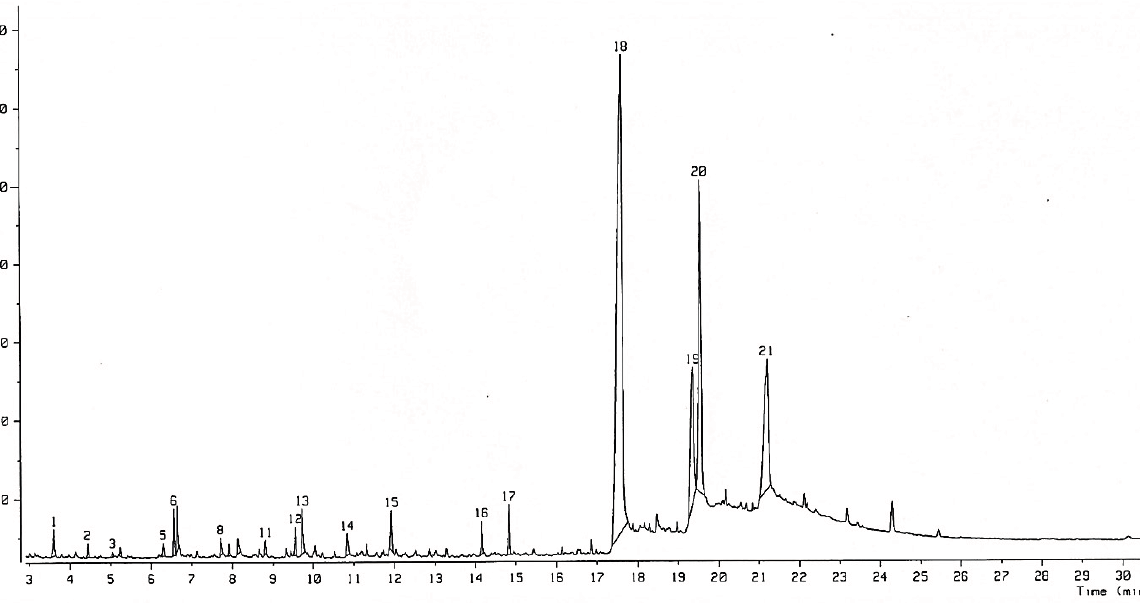
Figure 2. GC-MS analysis spectra with the identified number of compounds of Laminaria japonica L. essential oil